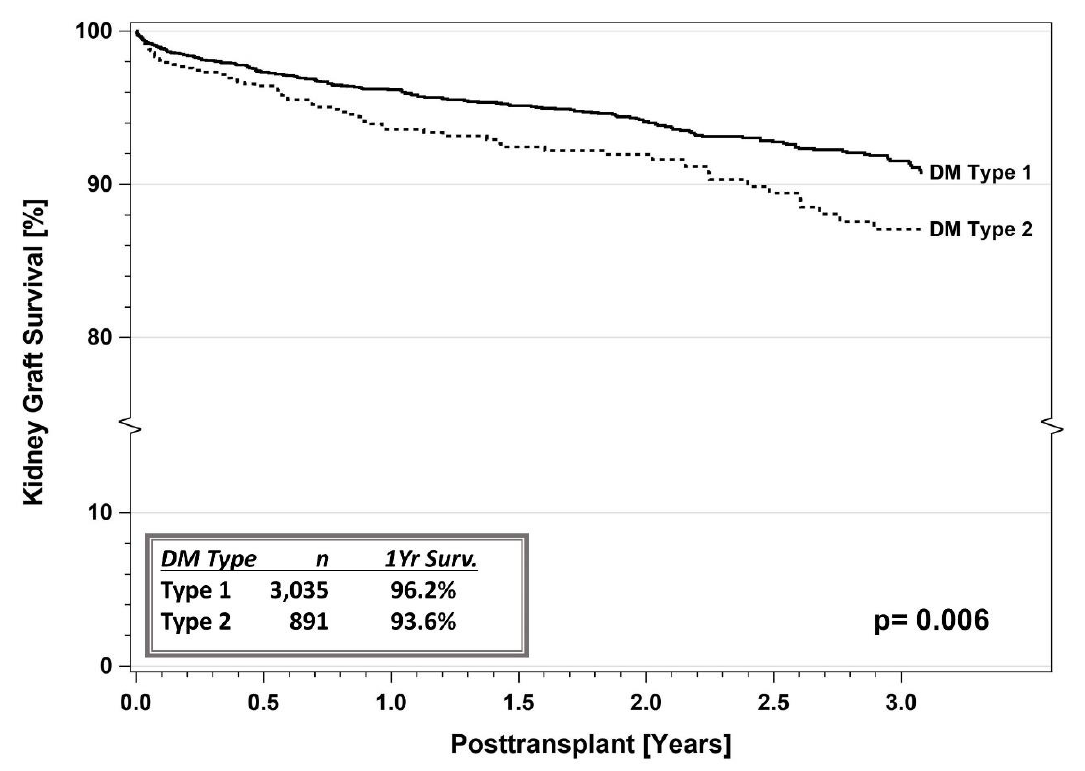
Figure 7. SPKT kidney graft survival according to diabetes type in the latest era (1 January 2017 – 31 December 2021) for US cases as reported to the IPTR. Surv. = Survival